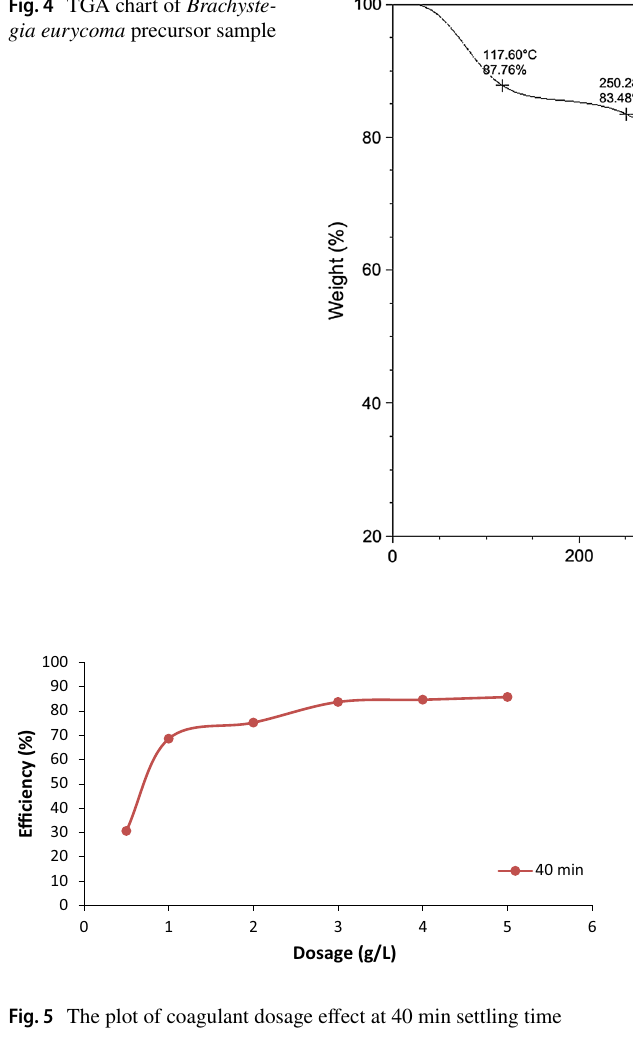
Fig. 5 The plot of coagulant dosage effect at 40 min settling